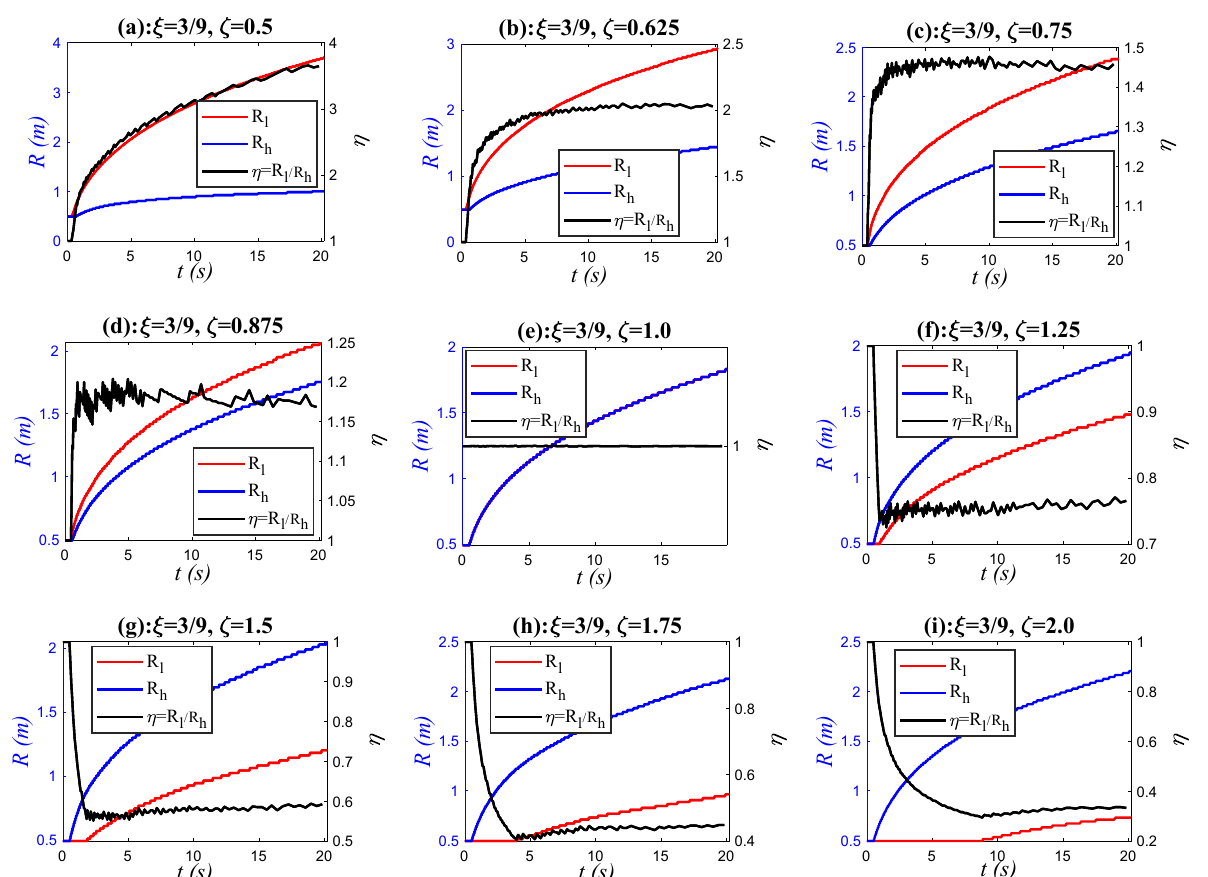
Figure 20. Relationships of the fracture “half-length” ( R l ), “half-height” ( R h ) and the fracture shape coefficient η with respect to time for Group 2 experiments with ξ = 3/9.